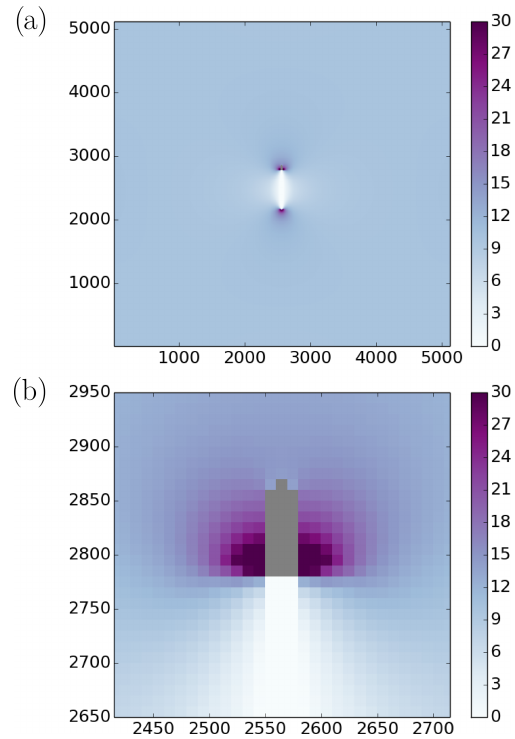
Figure 9. Pressure field at 10m resolution when including a digi- tized ship 90m long and 30m wide (in grey). The thickness field is 2m everywhere except a 600m long lead behind the ship. The nor- mal stresses at the boundaries are − 10kNm − 1 . The whole domain is shown in (a) , while (b) shows a zoom of the pressure field around the ship.